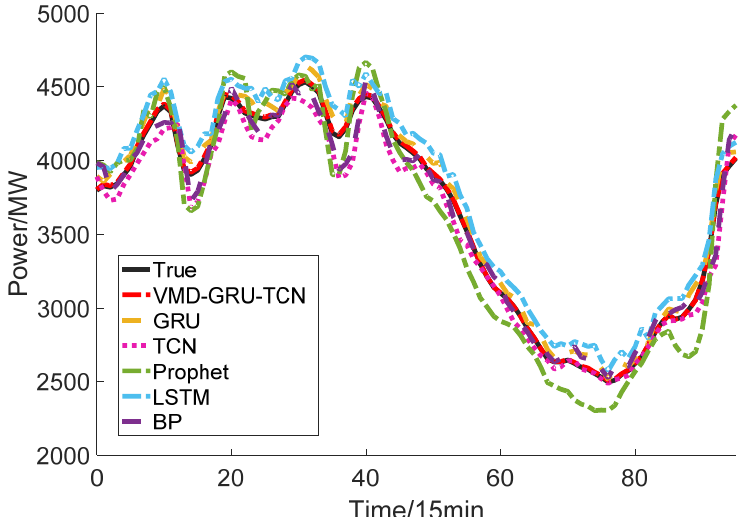
Figure 12. The forecasting result of data set 2.